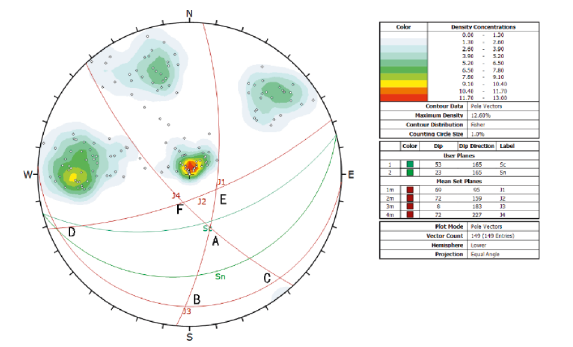
Figure 7: Discrete fracture